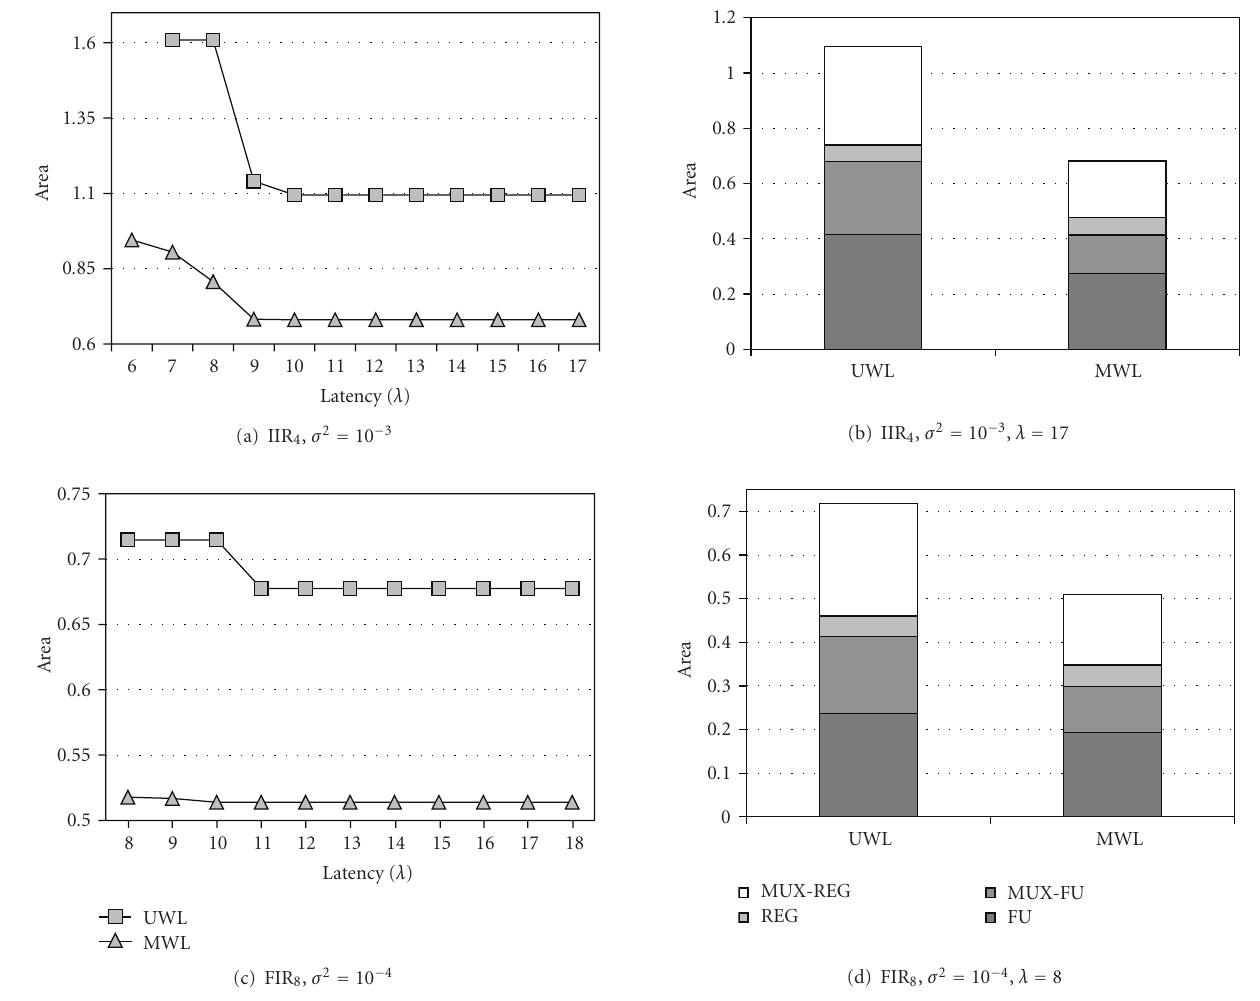
Figure 5: UWL versus MWL: homogeneous implementations (II).